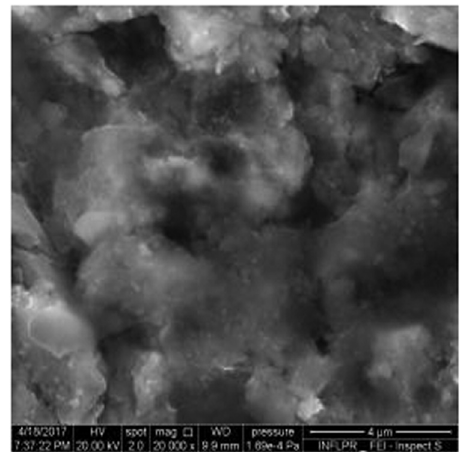
Figure 6: SEM image of sample S6 at a magni fi cation of 20k × .